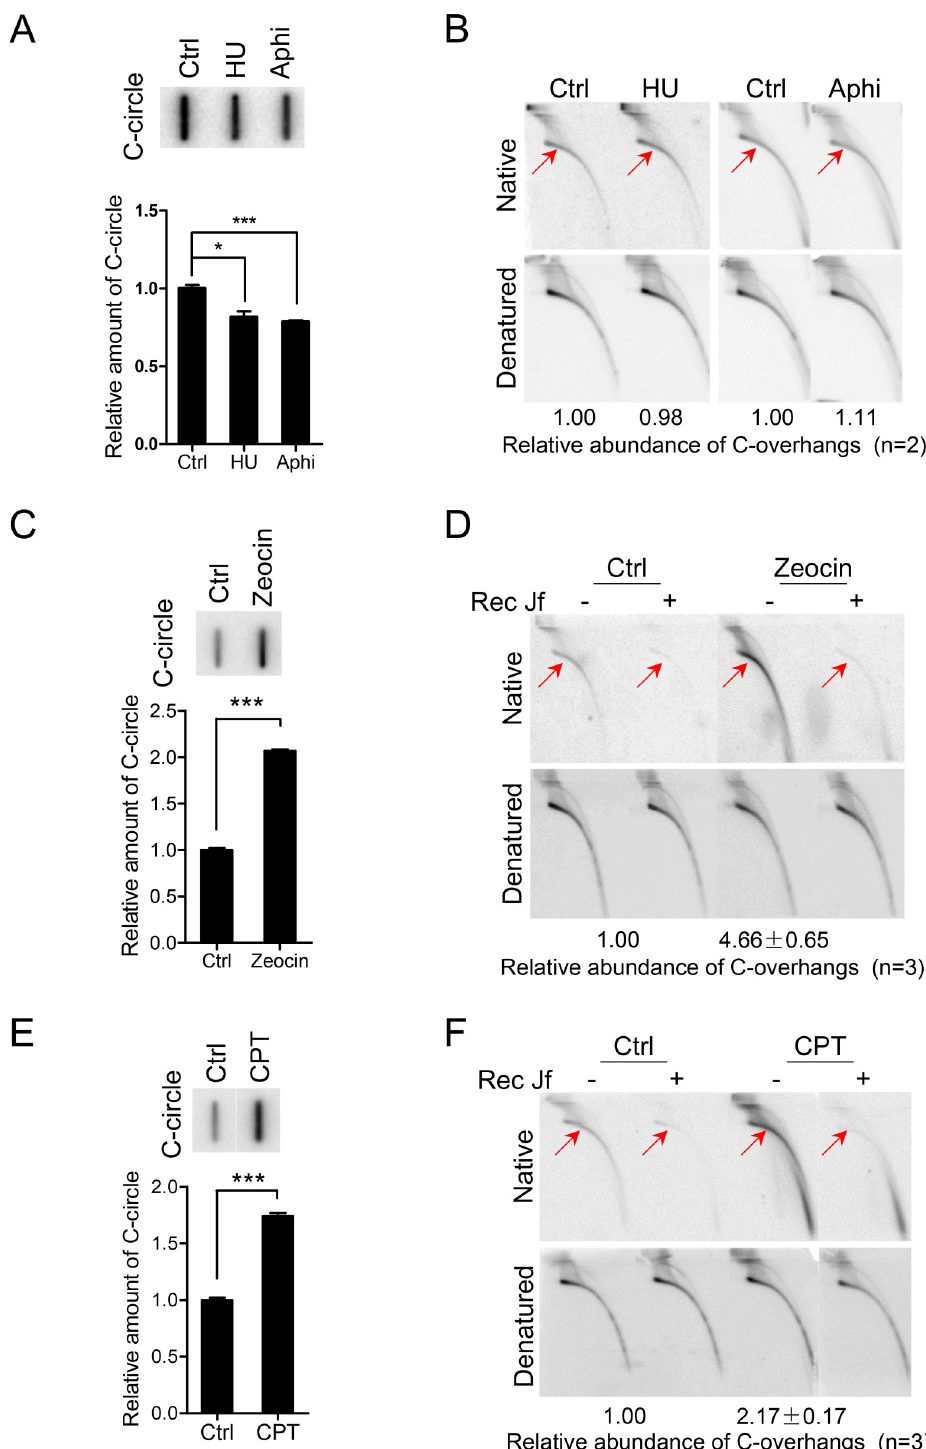
Fig 2. C-circles and 5’ C-overhangs are linked to DNA damage-induced replication fork collapse. (A) Replication fork stalling induced by HU or aphidicolin decreases abundance of C-circles in U2OS cells. U2OS cells were treated with HU (hydroxyurea, 2mM) or aphidicolin (Aphi, 1 μ g/mL) for 24h and genomic DNA was purified for C-circle assay. Error bars represent the mean ± SEM of three independent experiments. Two-tailed unpaired student’s t- test was used to calculate P-values. � P < 0.05, ��� P < 0.001. (B) Treatment of U2OS cells with HU or aphidicolin does